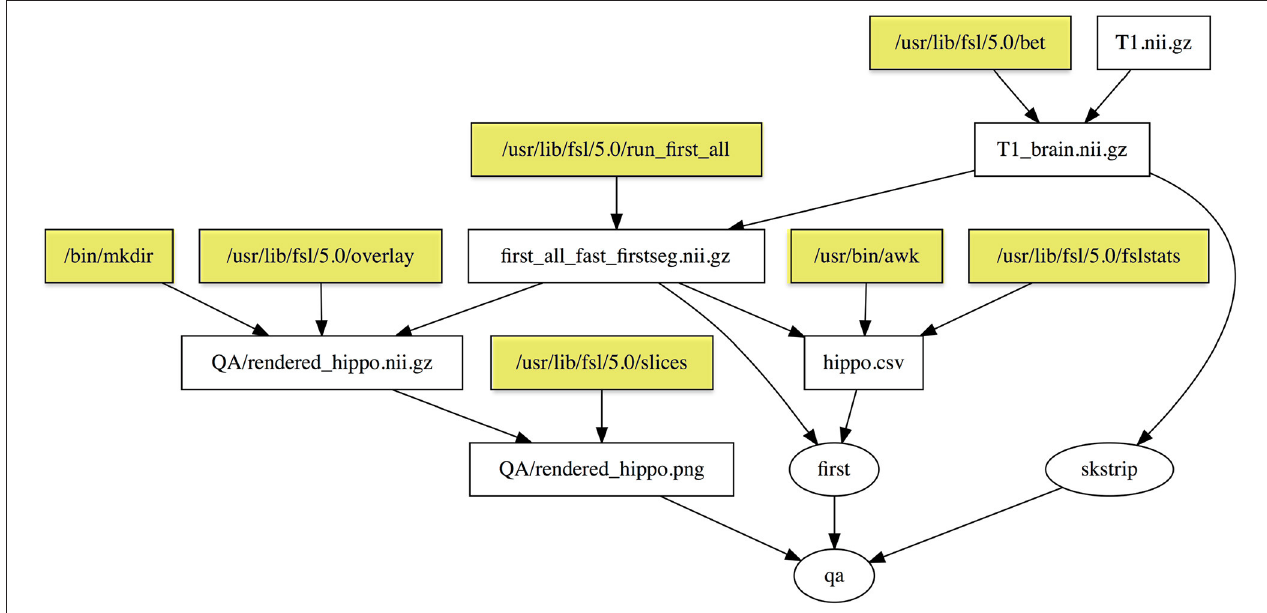
FIGURE 2 | Dependency graph of the “qa” target defined in the Makefile in Example 2. Rectangles represent files, and ellipses represent phony targets (that are defined for convenience and do not correspond to actual files). Yellow shaded rectangles are programs installed on the system that are part of the default Linux distribution or FSL utilities, and are important for provenance but not dependency